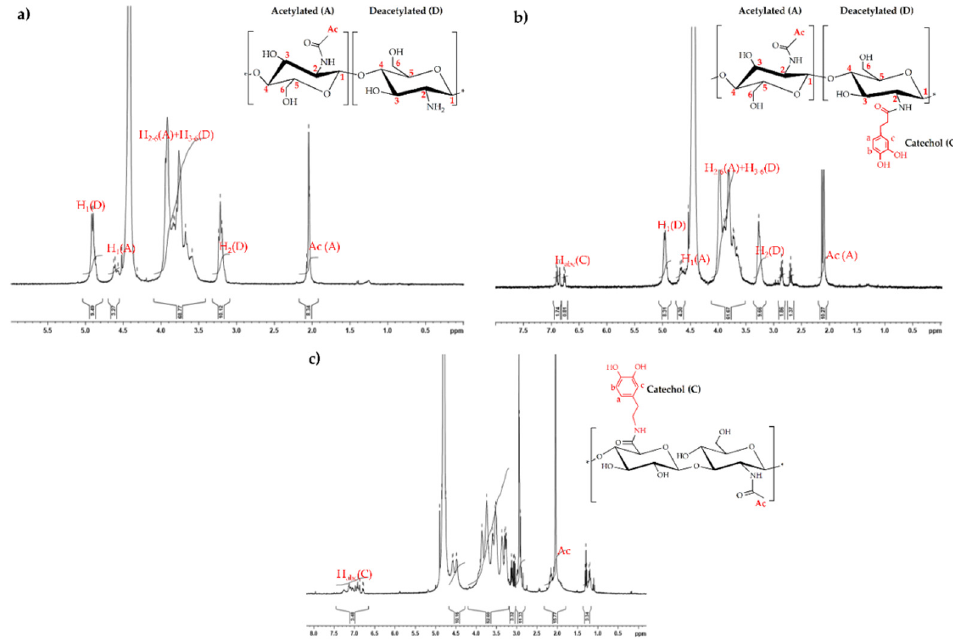
Figure A1. 1 H-nuclear magnetic resonance (NMR) spectra of ( a ) CHI, ( b ) CHIcat, and ( c ) HAcat, with their respective assignment of hydrogens. Table A1. Most relevant chemical shifts in 1 H-NMR spectra of CHI, CHIcat, and HAcat.